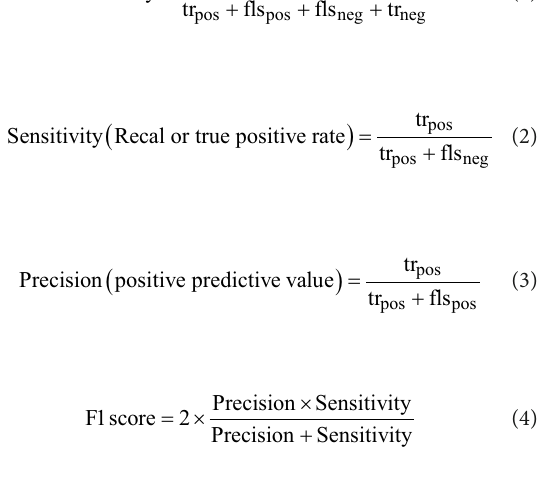
Algorithm 1. When a conflict arises between two possible outcomes, a code-word of 0 or several bits in the same code-word each equaling